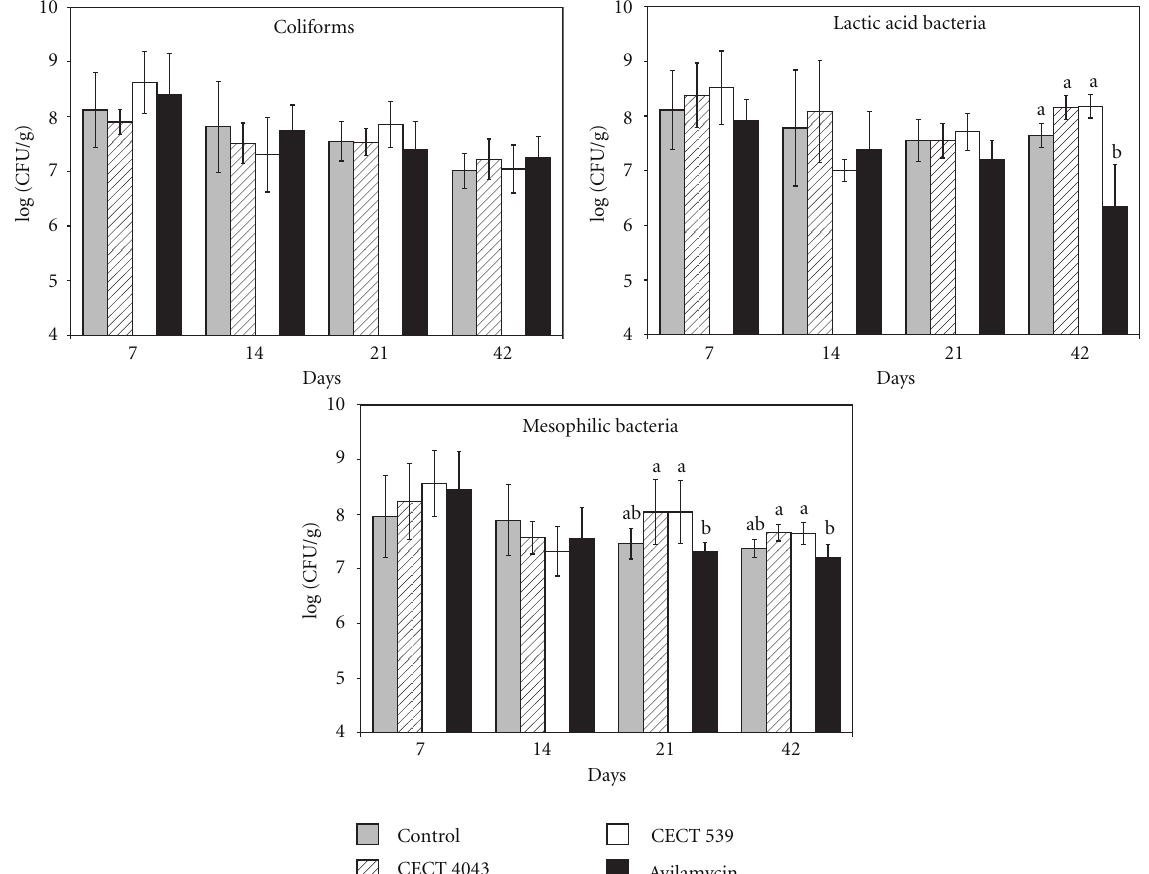
Figure 1: Viable plate counts (means ± standard deviations) of coliforms, lactic acid bacteria and mesophilic bacteria in the intestinal content of medium-growth Sasso X44 chickens fed with a non supplemented diet (control), or diets supplemented with the probiotic Lact. casei CECT 4043 or L. lactis CECT 539 preparations or avilamycin. a–c Means within columns followed by di ff erent letters are significantly ( P < 0 .